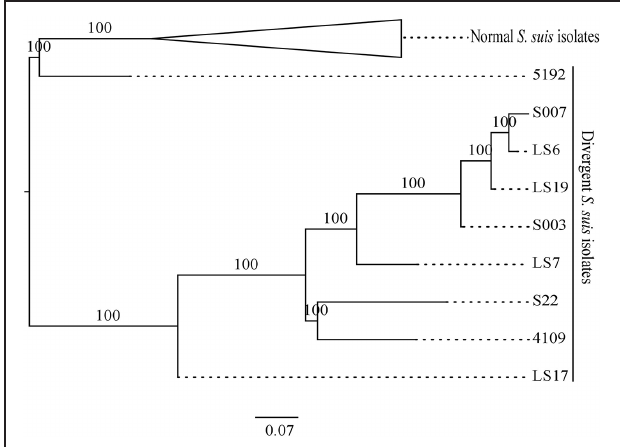
FIGURE 4 | Maximum likelihood phylogeny comparing the MLST allelic profiles of the divergent isolates with a selection of normal S. suis isolates. The branches with the normal S. suis isolates have been collapsed.